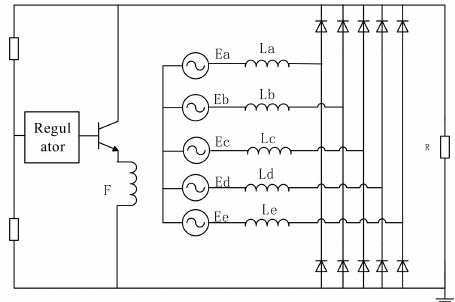
Figure 6. The five-phase rectifier and excitation of the